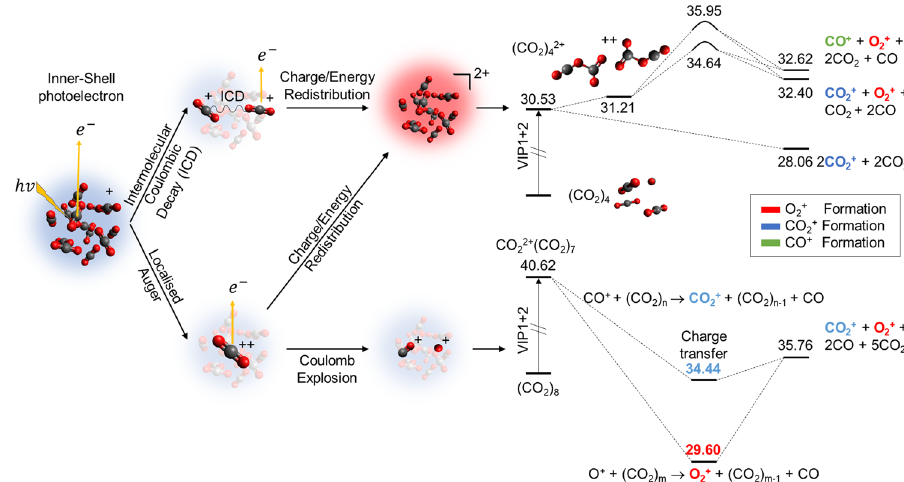
Fig. 4 Possible paths that a ð CO 2 Þ cluster can follow after core-electron ionisation followed by Auger emission. (i) Charge and internal energy are n — 2Y structures — in the potential energy surface. (ii) Coulomb explosion of a redistributed along the cluster, which leads to the formation of stable ð CO 2 Þ 2 þ 4 ! O þ þ CO þ , which leads to the reaction of both charged species with the surrounding CO single molecule CO 2 þ 2 molecules. Relevant points in the 2 potential energy surface leading to the most important channels are shown, energy values are given in eV and refereed to the neutral cluster.